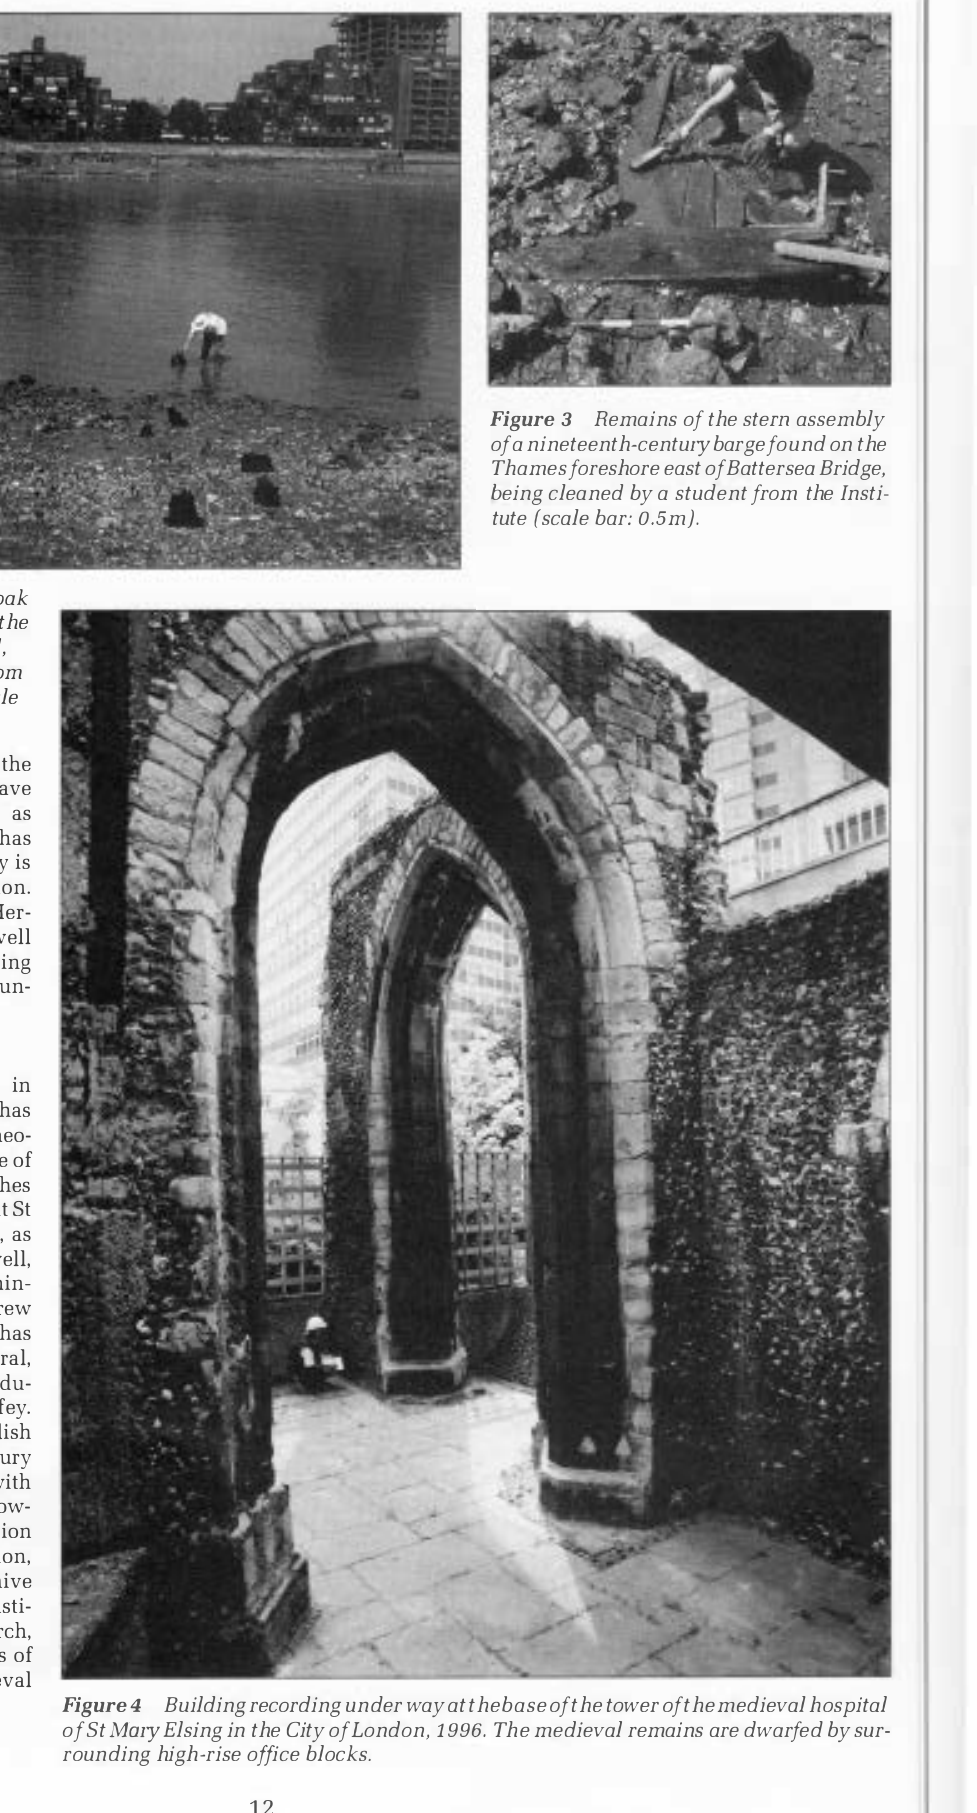
Figure 4 Building recording under way at the base of the tower of the medieval hospital of St Maiy El sing in the City of London, 1996. The medieval remains are dwarfed by sur­ rounding high-rise office